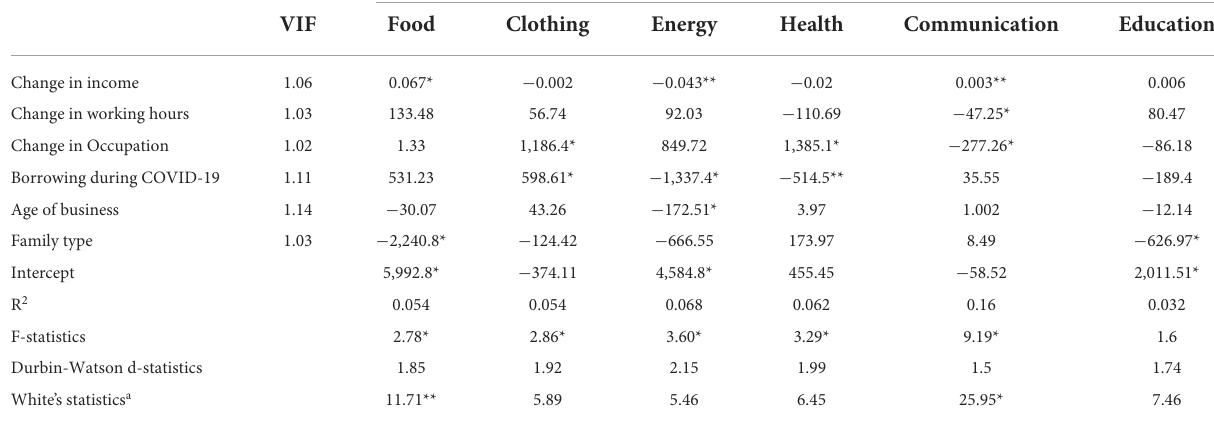
TABLE 4 Mitigating factors of consumption during